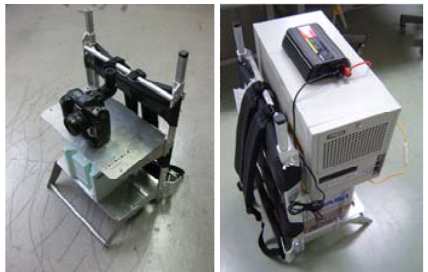
Figure 1. Inertial single photogrammetry instrument